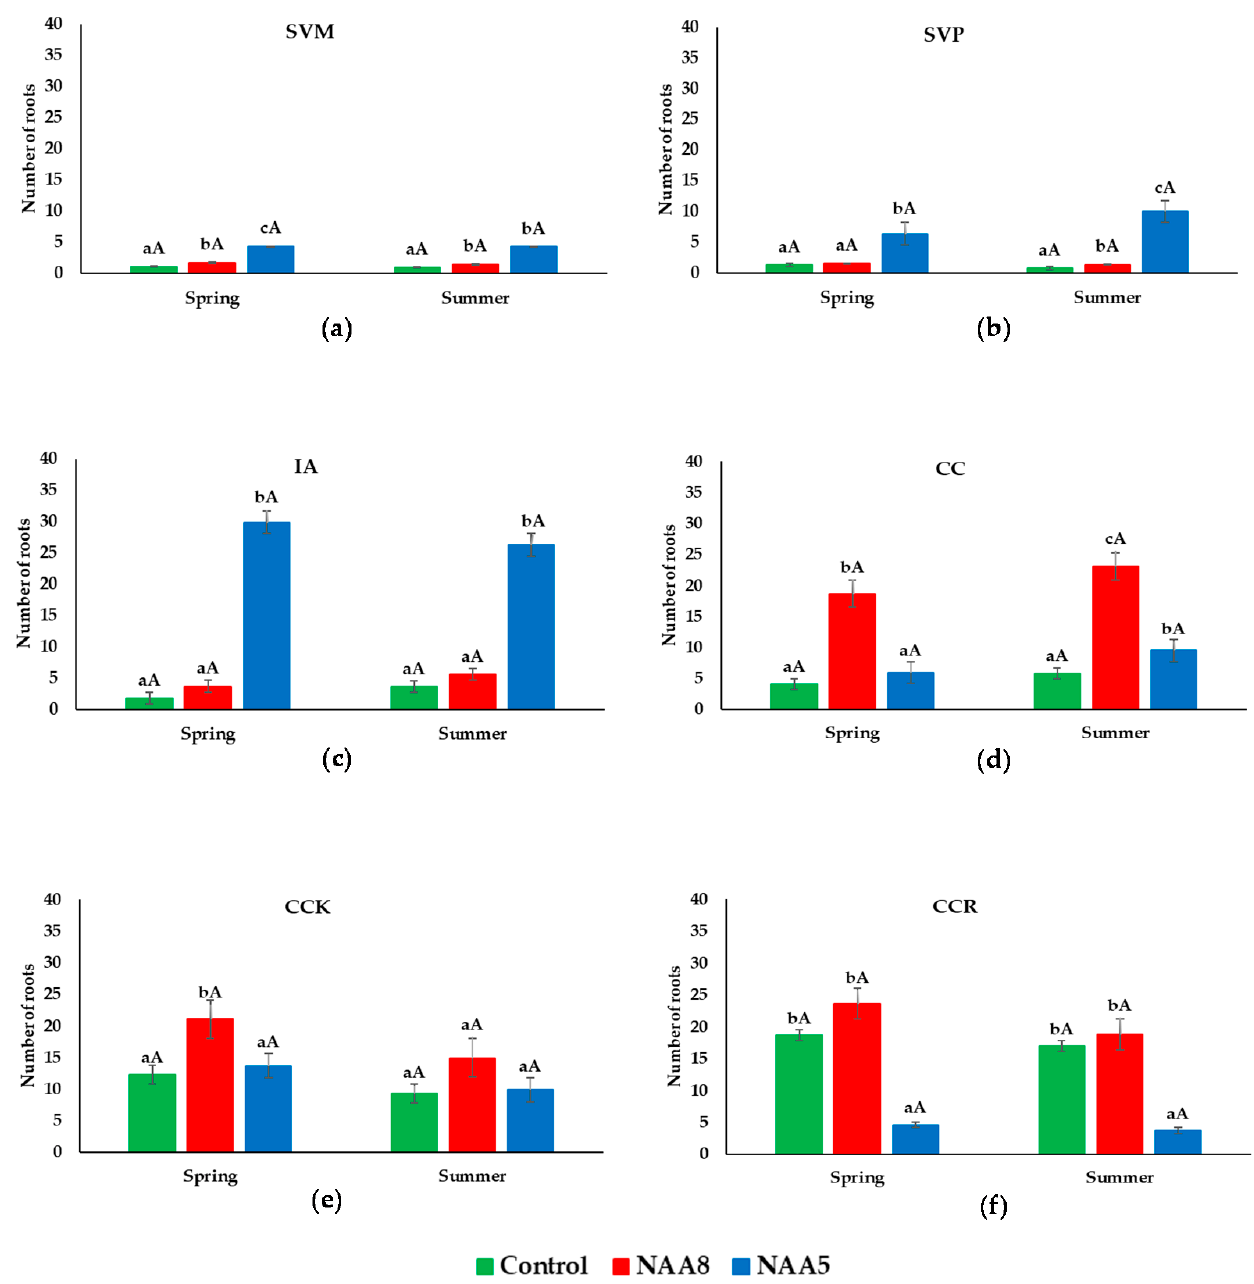
Figure 3. Effect of rooting stimulants (NAA8 and NAA5) on the number of roots in the six selected ornamental shrubs: ( a ) Syringa vulgaris ‘Mme Lemoine’ (SVM); ( b ) Syringa vulgaris ‘President Grevy’ (SVP); ( c ) Ilex aquifolium (IA); ( d ) Cotinus coggygria (CC); ( e ) Cotinus coggygria ‘Kanari’ (CCK); ( f ) Cotinus coggygria ‘Royal Purple’ (CCR). Bars represent the means ± SE ( n = 30). Different lowercase letters above the bars indicate significant differences between the treatments, and different uppercase letters indicate the significant differences between the spring and summer propagated cuttings, according to Tukey’s test ( α = 0.05).